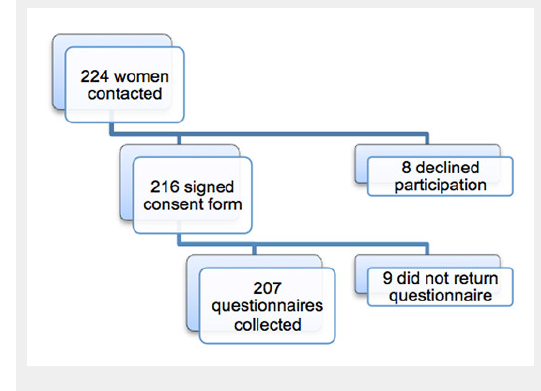
Table 1: Baseline characteristics of the participants. Results are reported as n (%) or mean [standard deviation]. If unspecified, N = 207. Mean age (years)